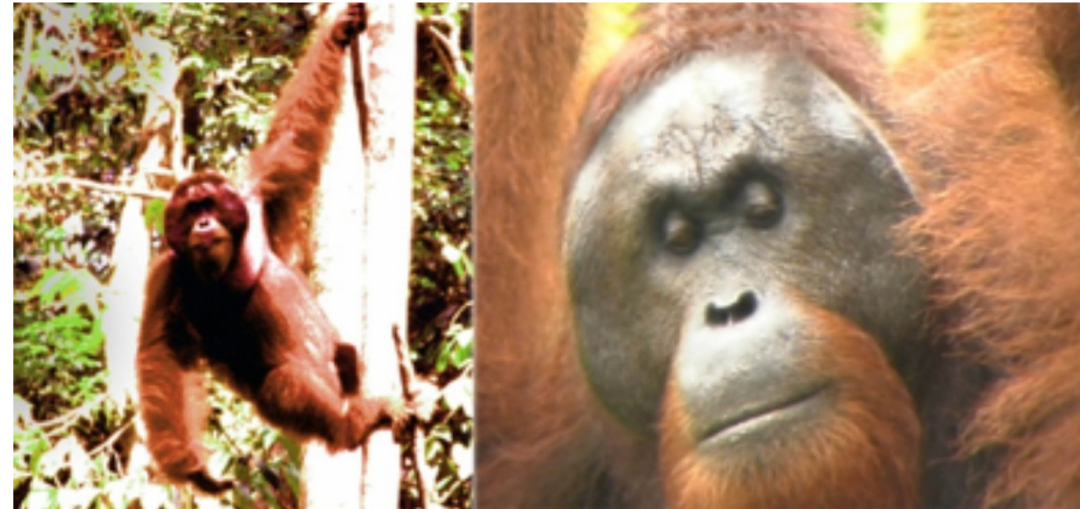
Figure 2. ( Left ): Adult male orang-utan (Simbo), an imposing figure, some 80 kg in weight, nimble, and very strong (note the strong, long arms). This was the moment when he appeared at the other end of the clearing, some 50 m away. ( Right ): The head of an orang-utan male is considerable larger than a human head, exaggerated by the cheek pads (flanges) (Photocredit